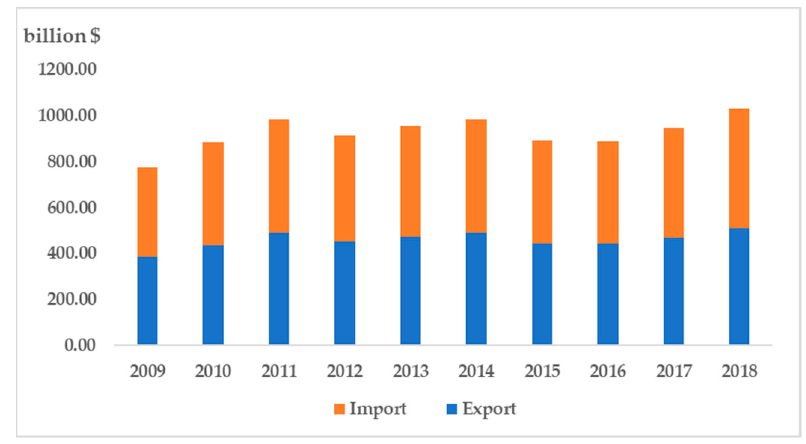
Figure 2. Trade value of forest products from 2009 to 2018. Date source: UN Comtrade.